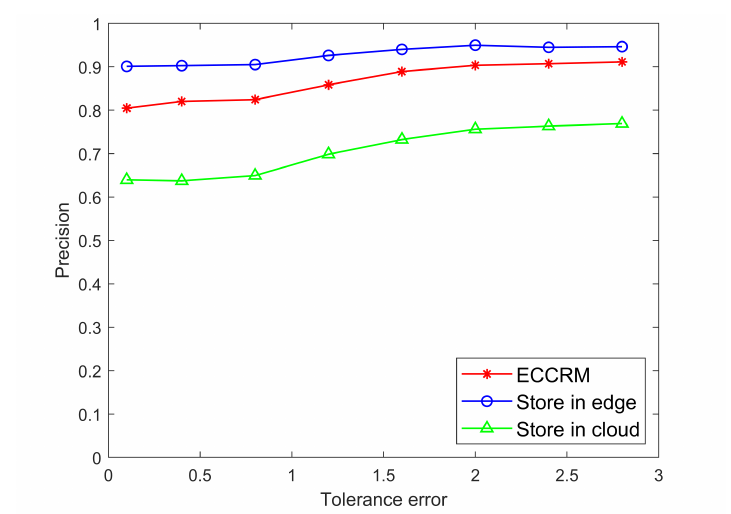
Figure 10. Comparison of precision of different store scheme under different tolerance errors.